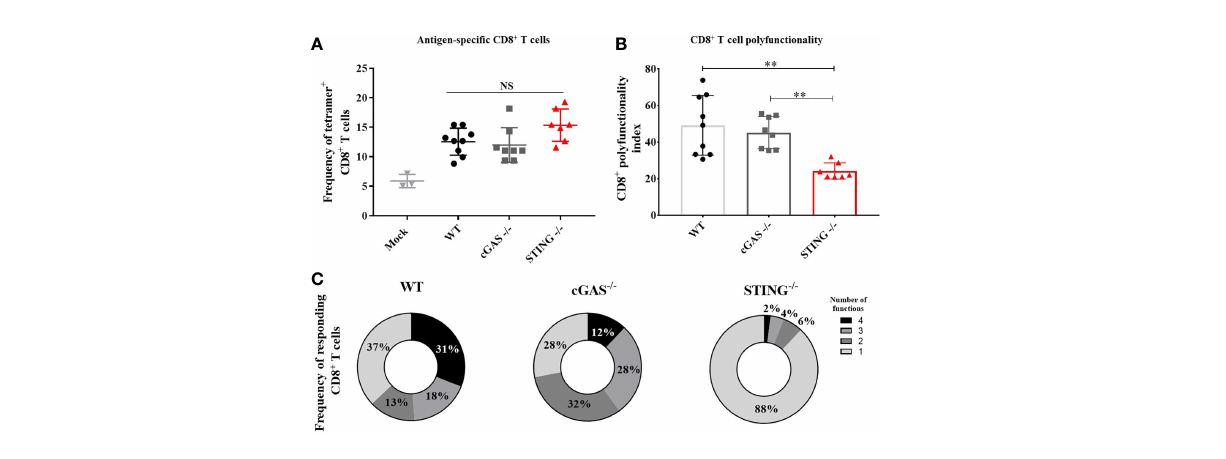
FIGURE 2 | STING is required for DNA vaccine induction of antigen-speci fi c CD8 + T cell polyfunctionality. WT, cGAS -/- and STING -/- mice were IM/EP vaccinated with pNP. Mice were sacri fi ced 21-days post-vaccination and splenocytes were isolated and made into single cell suspensions. (A) The frequency of tetramer positive cells within CD8 + T cells were measured for each genotype using a MHC-I tetramer that presents the NP immunodominant peptide (NP 366-374 ) for C57bl/6. CD8 + T cells and cells were gated as outlined in Supplementary Figure 3B . (B) Polyfunctional scores were determined by stimulating splenocytes overnight with 1 m g/ml of NP 366-375 followed by ICS staining for IL-2, TNF- a , IFN- g and CD107a/GranzymeB and analyzed by fl ow cytometry as shown in Supplementary Figure 4 . Polyfunctionality scores were calculated as described in the methods and Larsen et al (17). (C) Pie charts show the relative average proportion of CD8 + T cells producing 1-4 immune factors (IL-2, TNF- a , IFN- g and/ or CD107a/GranzymeB) after NP 366-374 stimulation. Three independent experiments consisting of 3-9 mice were performed consisting of 3-9 mice; representative data are the average± SD of 3-9 mice/genotype. Groups were compared using a one-way ANOVA, **p<0.01 and NS, not signi fi cant.